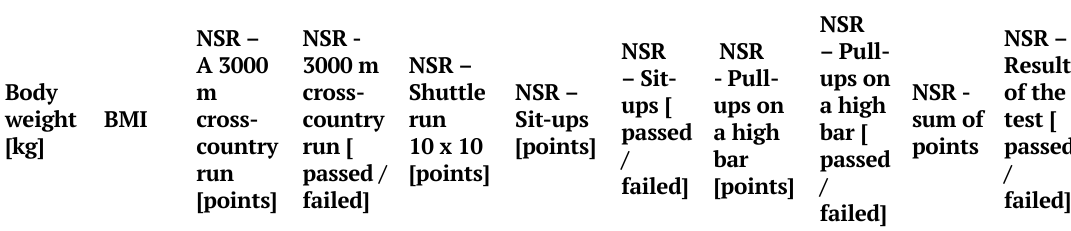
Table 3. Correlation of body weight, BMI of the subjects, scores and pass rates in individual tests in the NSR physical fitness